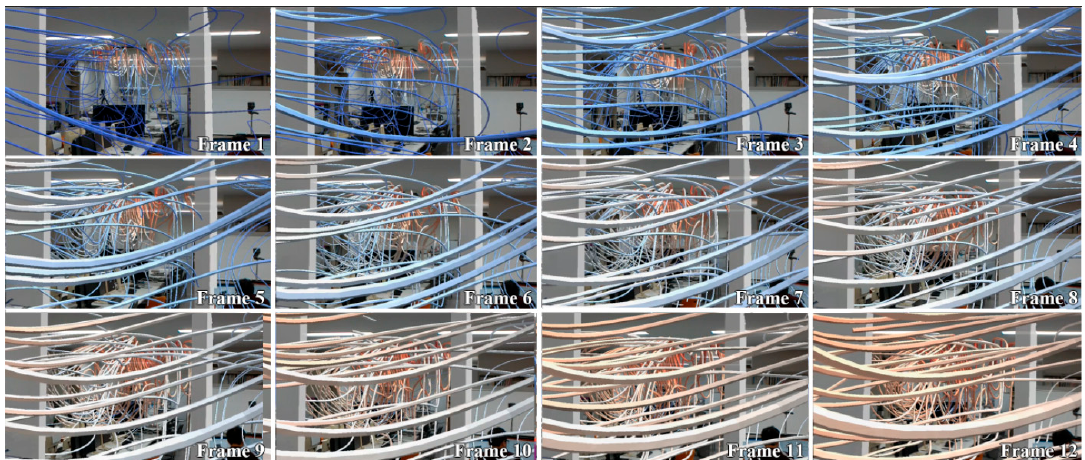
Figure 16. Animated CFD result of case c3 in the HMD.